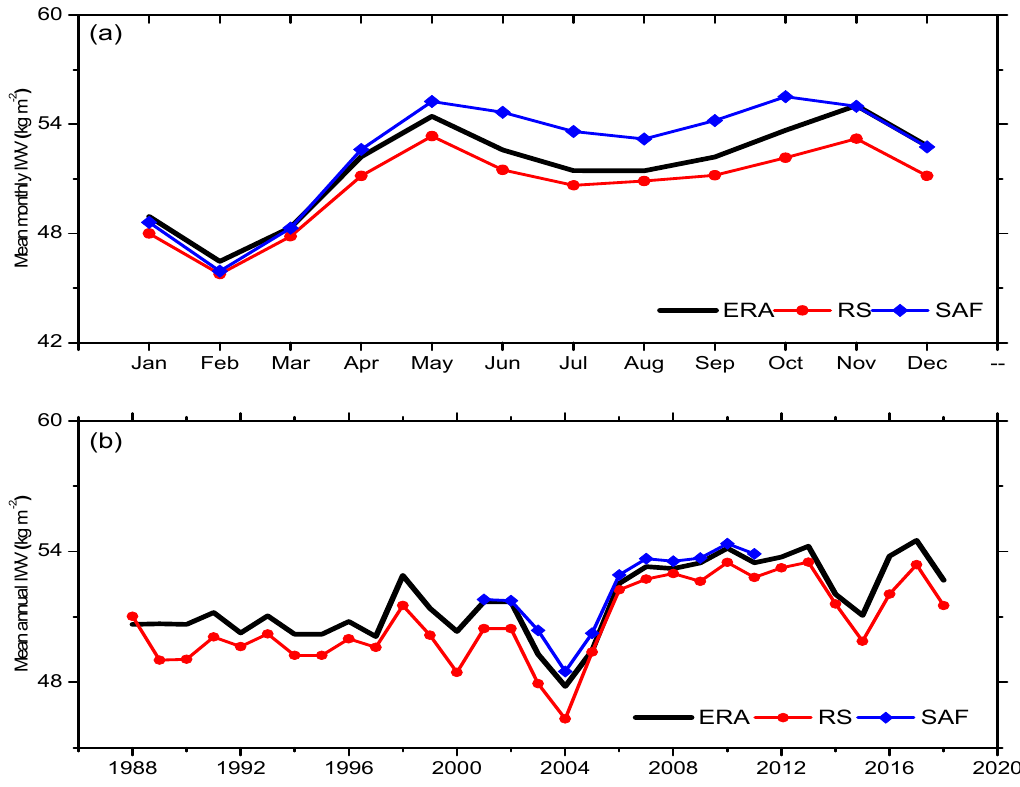
Figure 4. ( a ) Seasonal cycle of monthly mean and ( b ) Annual mean time series of IWV over Peninsular Malaysia for ERA-Interim (1988–2018), radiosonde (1988–2018), and CM-SAF (2001–2011)